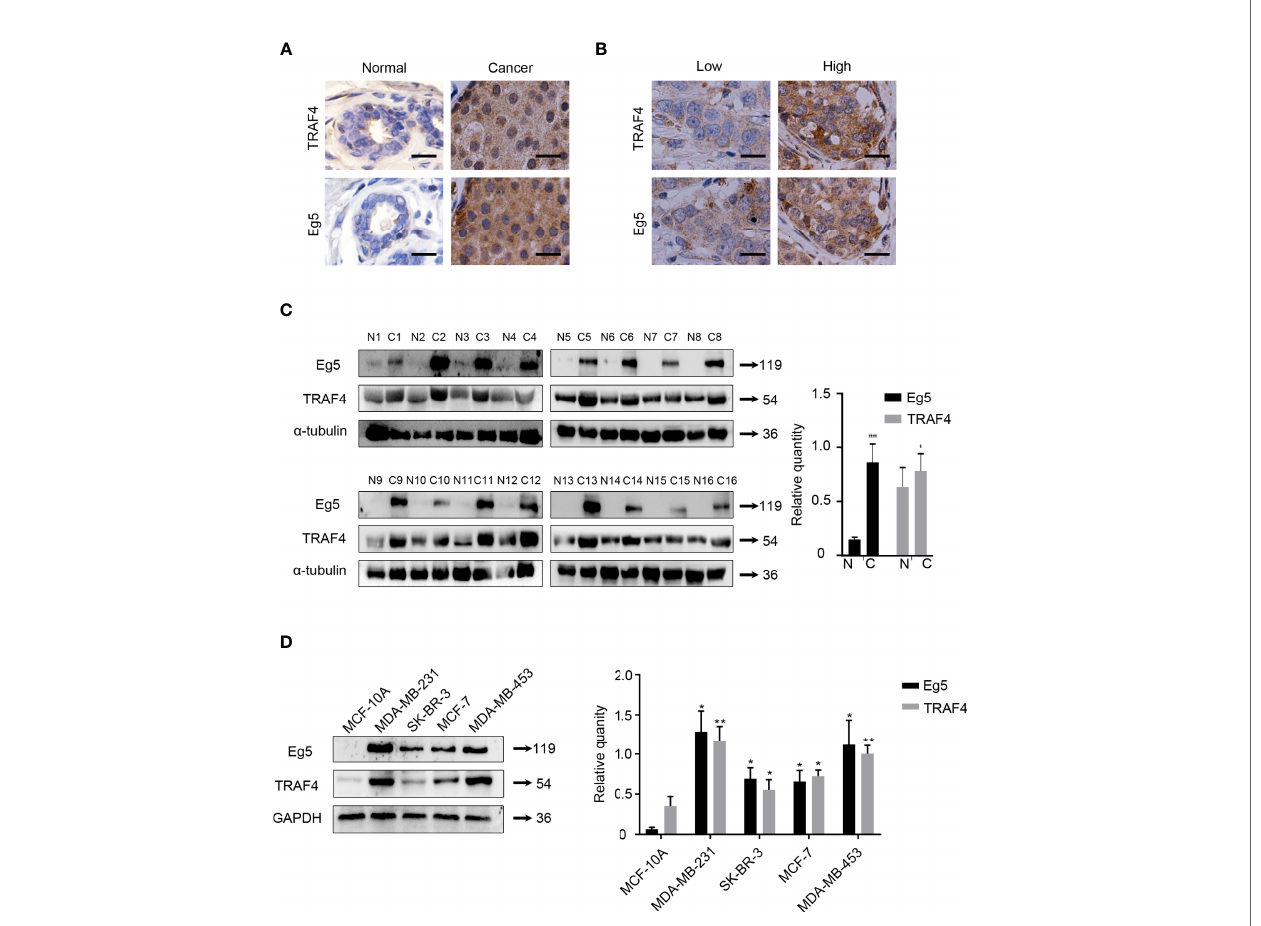
FIGURE 1 | TRAF4 and Eg5 are highly expressed in breast cancer and there is a positive correlation between TRAF4 and Eg5 protein level levels. (A) Immunohistochemical analysis demonstrating the protein level and localization of TRAF4 and Eg5 in normal breast tissue (NBT) and breast cancer tissue (BCT). Bar, 20 m m. (B) The protein level of Eg5 was positively correlated with TRAF4 protein level levels in breast cancer patient tissue. Bar, 20 m m. (C) Protein level and correlation of TRAF4 and Eg5 in 16 breast cancer patient tissues and paired normal tissues, as detected by western blot. a -tubulin was used as an internal